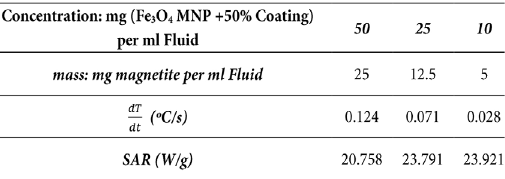
Table 2. Theoretical and experimental estimations for ∆T based on Equation